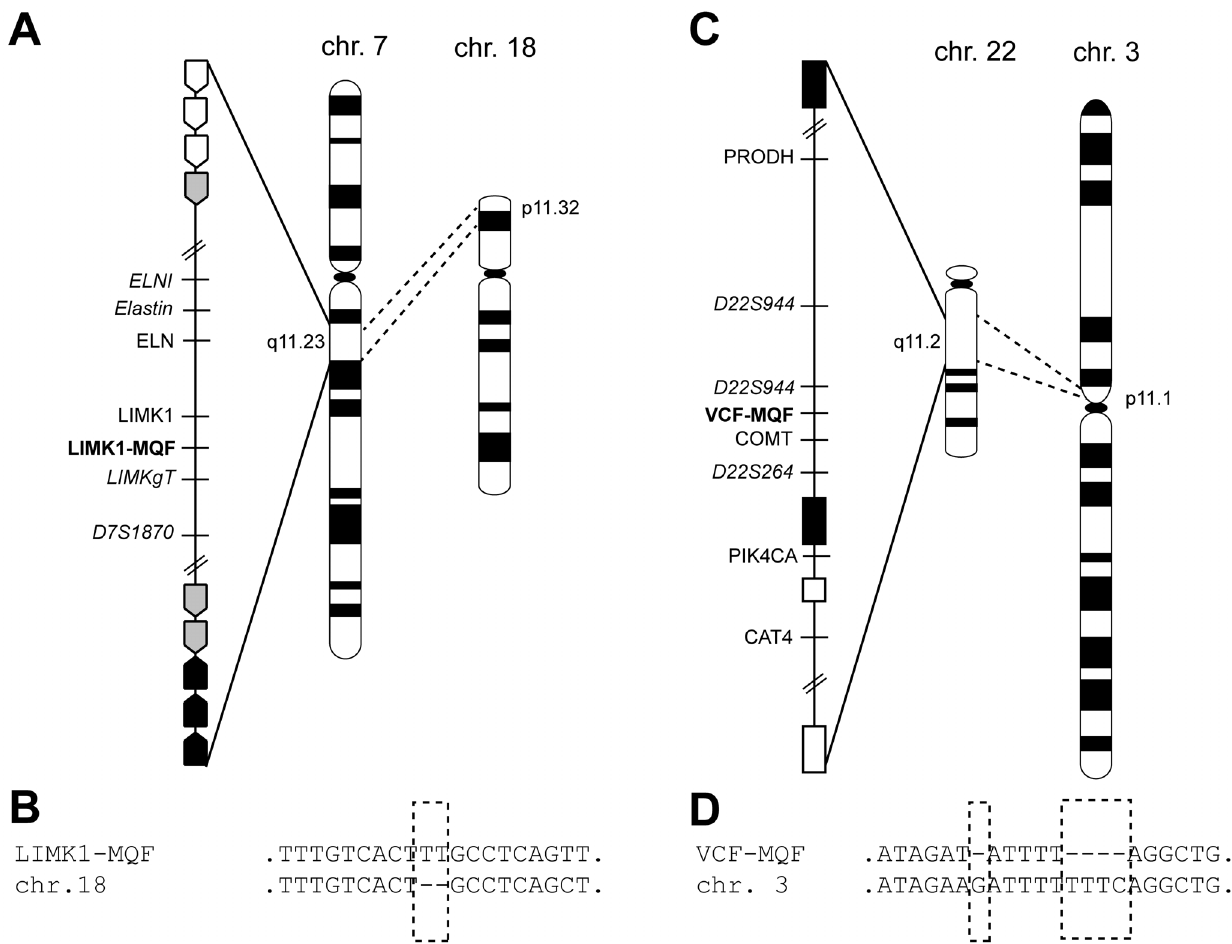
Figure 1. Schematic overview of MQF-PCR primer selection for Williams-Beuren and Velocardiofacial syndromes critical regions (not drawn to scale). A) Williams-Beuren critical region at 7q11.23 contains centromeric (white arrow), middle (grey arrow), and telomeric (black arrow) blocks of low copy repeats. The minimal critical region in this study represents the region that is flanked by the inner block of low copy repeats. Sequence similarity search identified a region that can be amplified using the LIMK1-MQF primers (bold) and has significant similarity to homologous region at 18p11.32. B) Multiple sequence alignment of the LIMK1-MQF region with its homologous region on chromosome 18. A deletion of 2 bp (dashed box) differentiates the two fragments amplified using the same primer pair. C) Velocardiofacial critical region at 22q11.2 is delimited by 4 blocks of low copy repeats. The minimal critical region in this study represents the region that is flanked by two blocks of low copy repeats most proximal to the centromere (black boxes). Sequence similarity search identified a region within the critical region that can be amplified using the VCF-MQF primers (bold) with significant similarity to a homologous region at 3p11.1. D) Multiple sequence alignment of the VCF-MQF region with its homologous region on chromosome 3. A deletion of 5 bp (dashed box) differentiates the two fragments amplified using the same primer pair. Microsatellite markers (italicized) and Real-Time PCR primers used in molecular diagnosis of patients are shown in both panels.